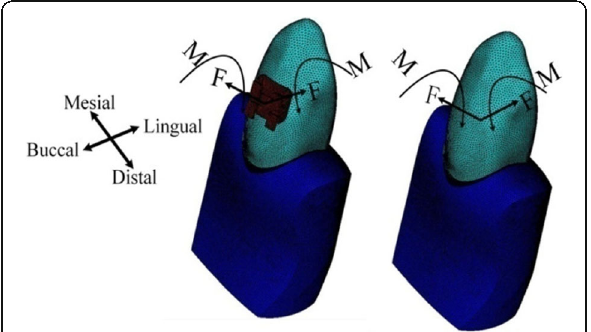
Fig. 1 A constant force and varied moments applied to the models with bracket and without